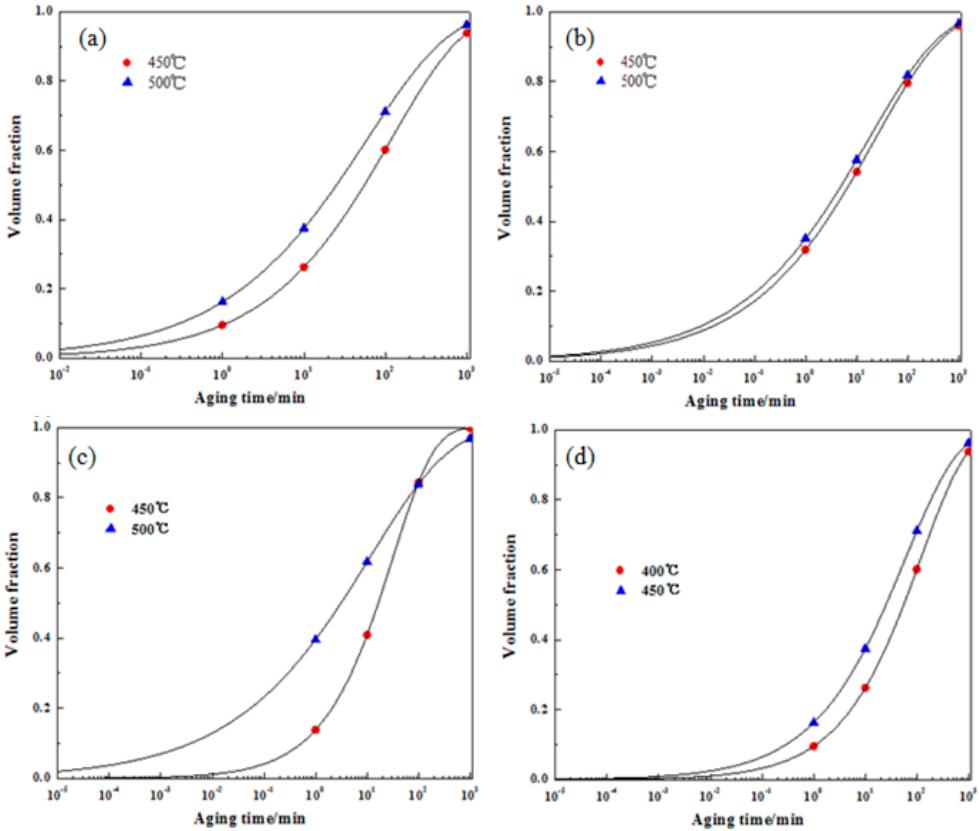
Figure 9. Kinetic curves of phase transformation of the experimental alloys ( a ) S1 alloy. ( b ) S2 al- c ) S3 alloy. ( d ) S4 loy. ( c ) S3 alloy. ( d ) S4 alloy. (